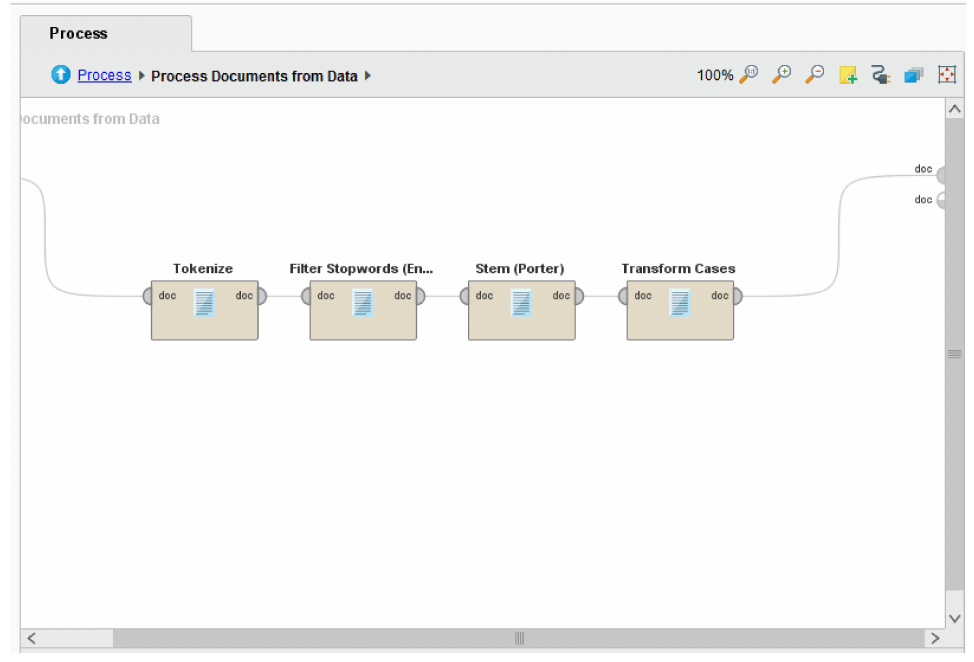
Fig. 4 The visualization of data pre-processing in